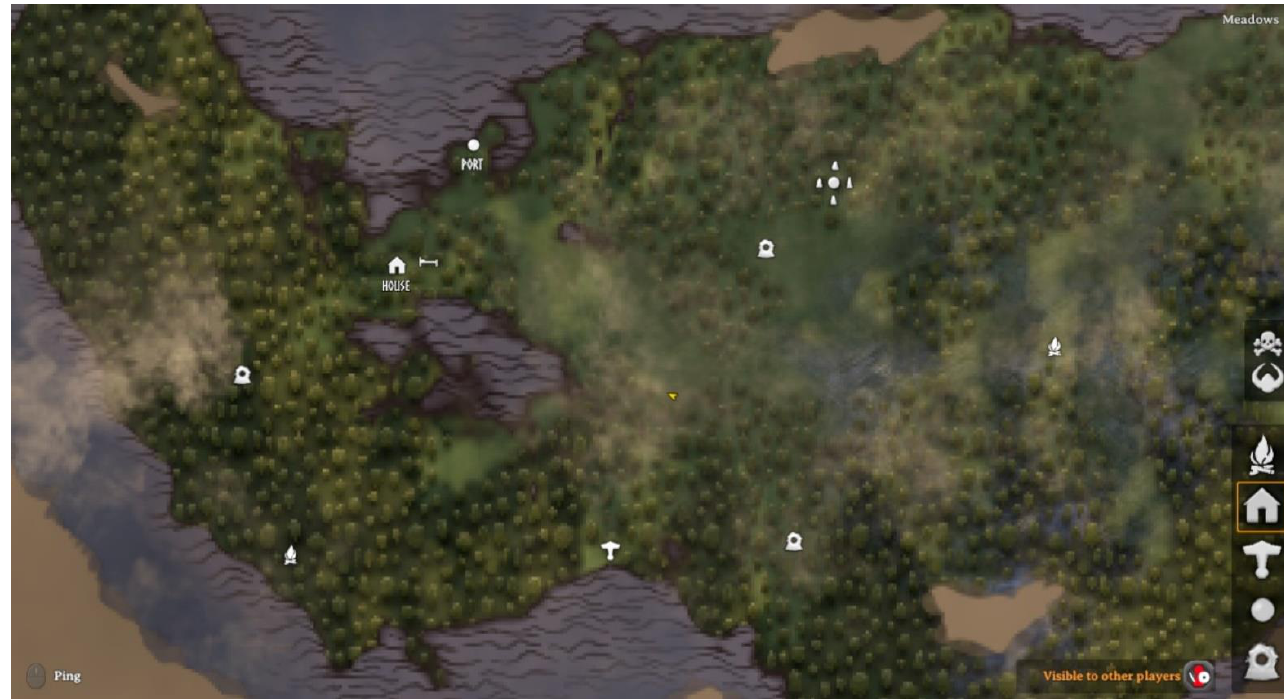
Figure 1. Map from the Valheim game.